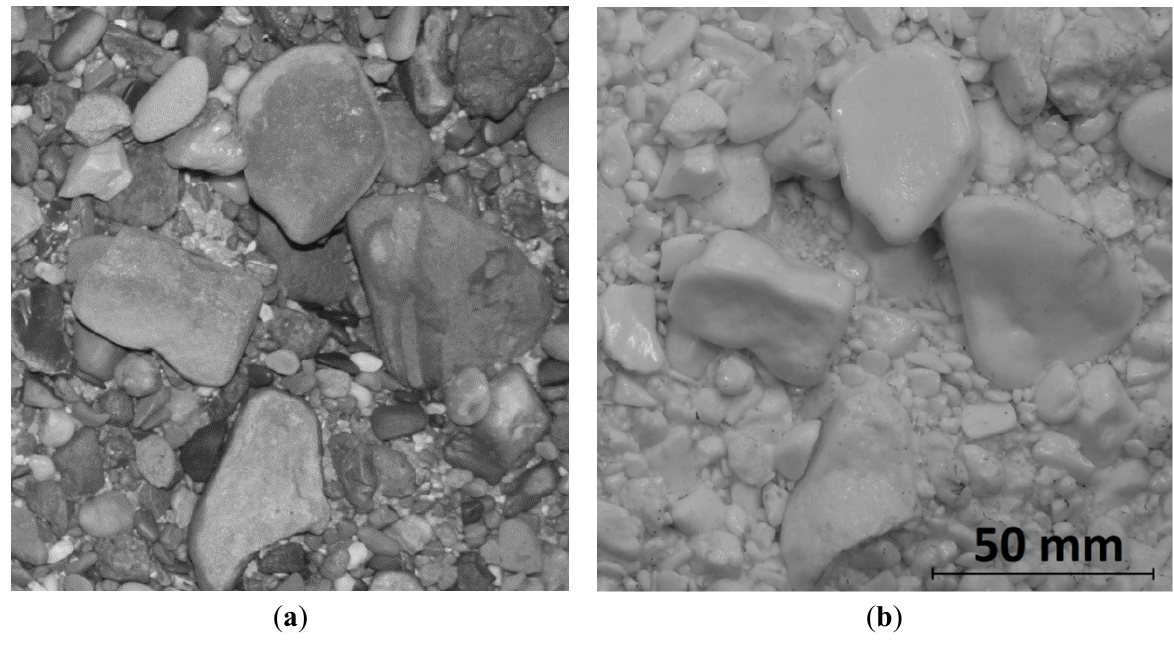
Figure 3. ( a ) Detail of the original armor layer; ( b ) Detail of the artificial